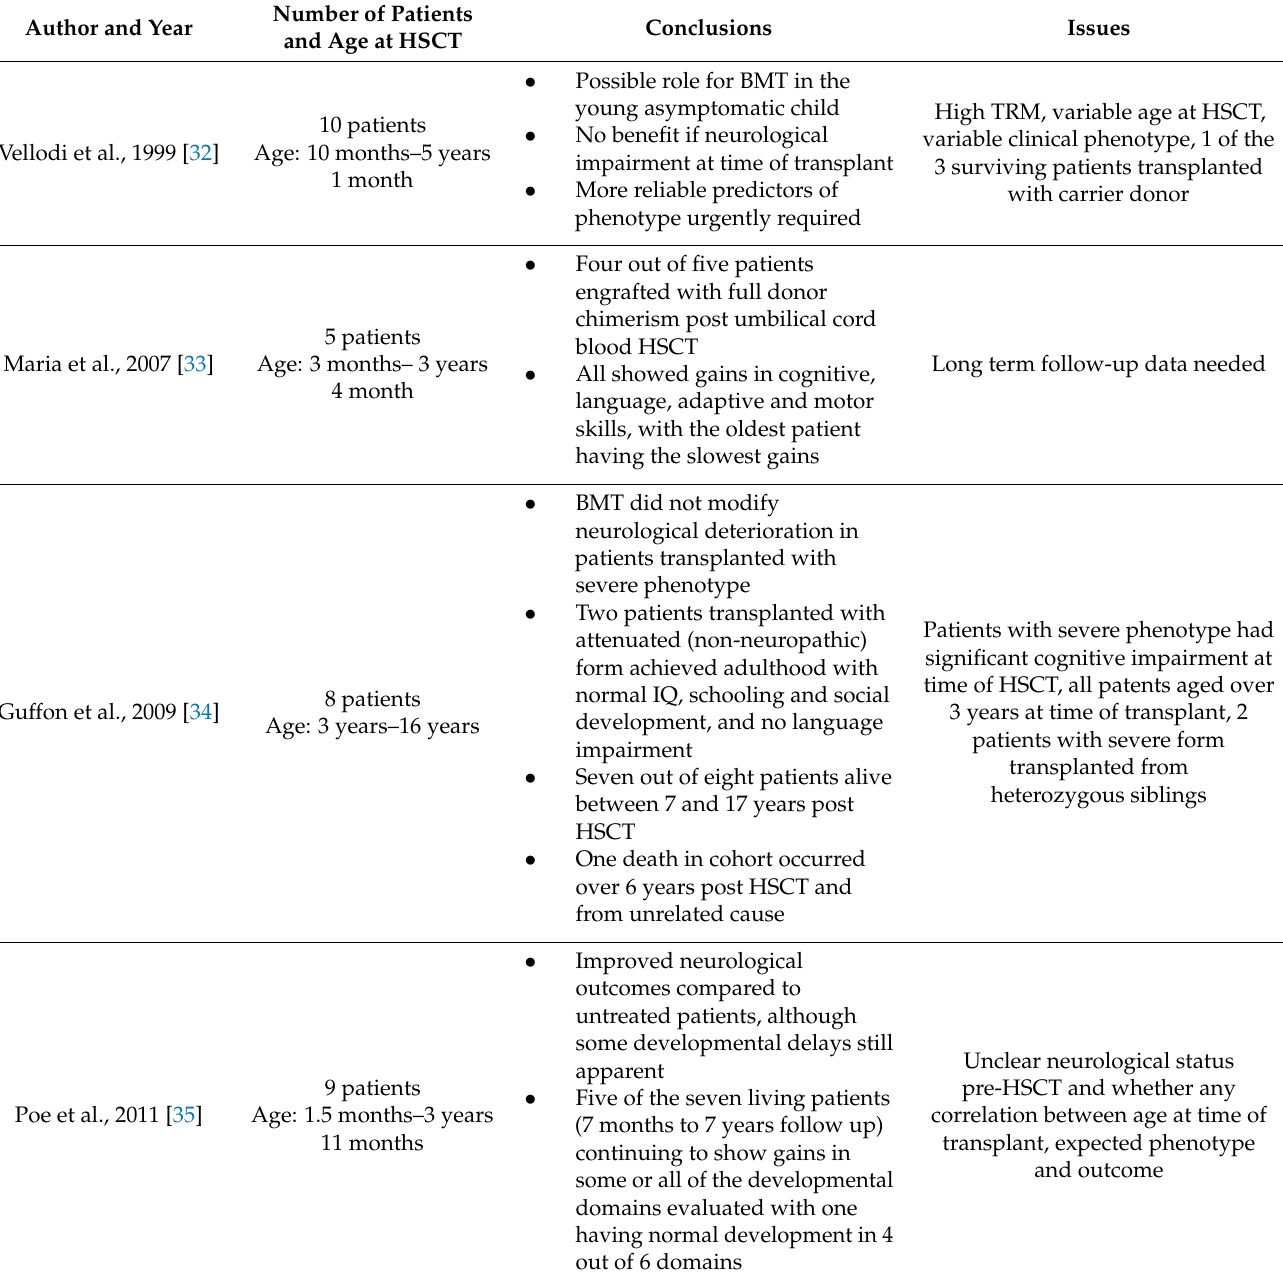
Table 1. Summary of the main conclusions and limitations of available literature assessing the neurological impact of